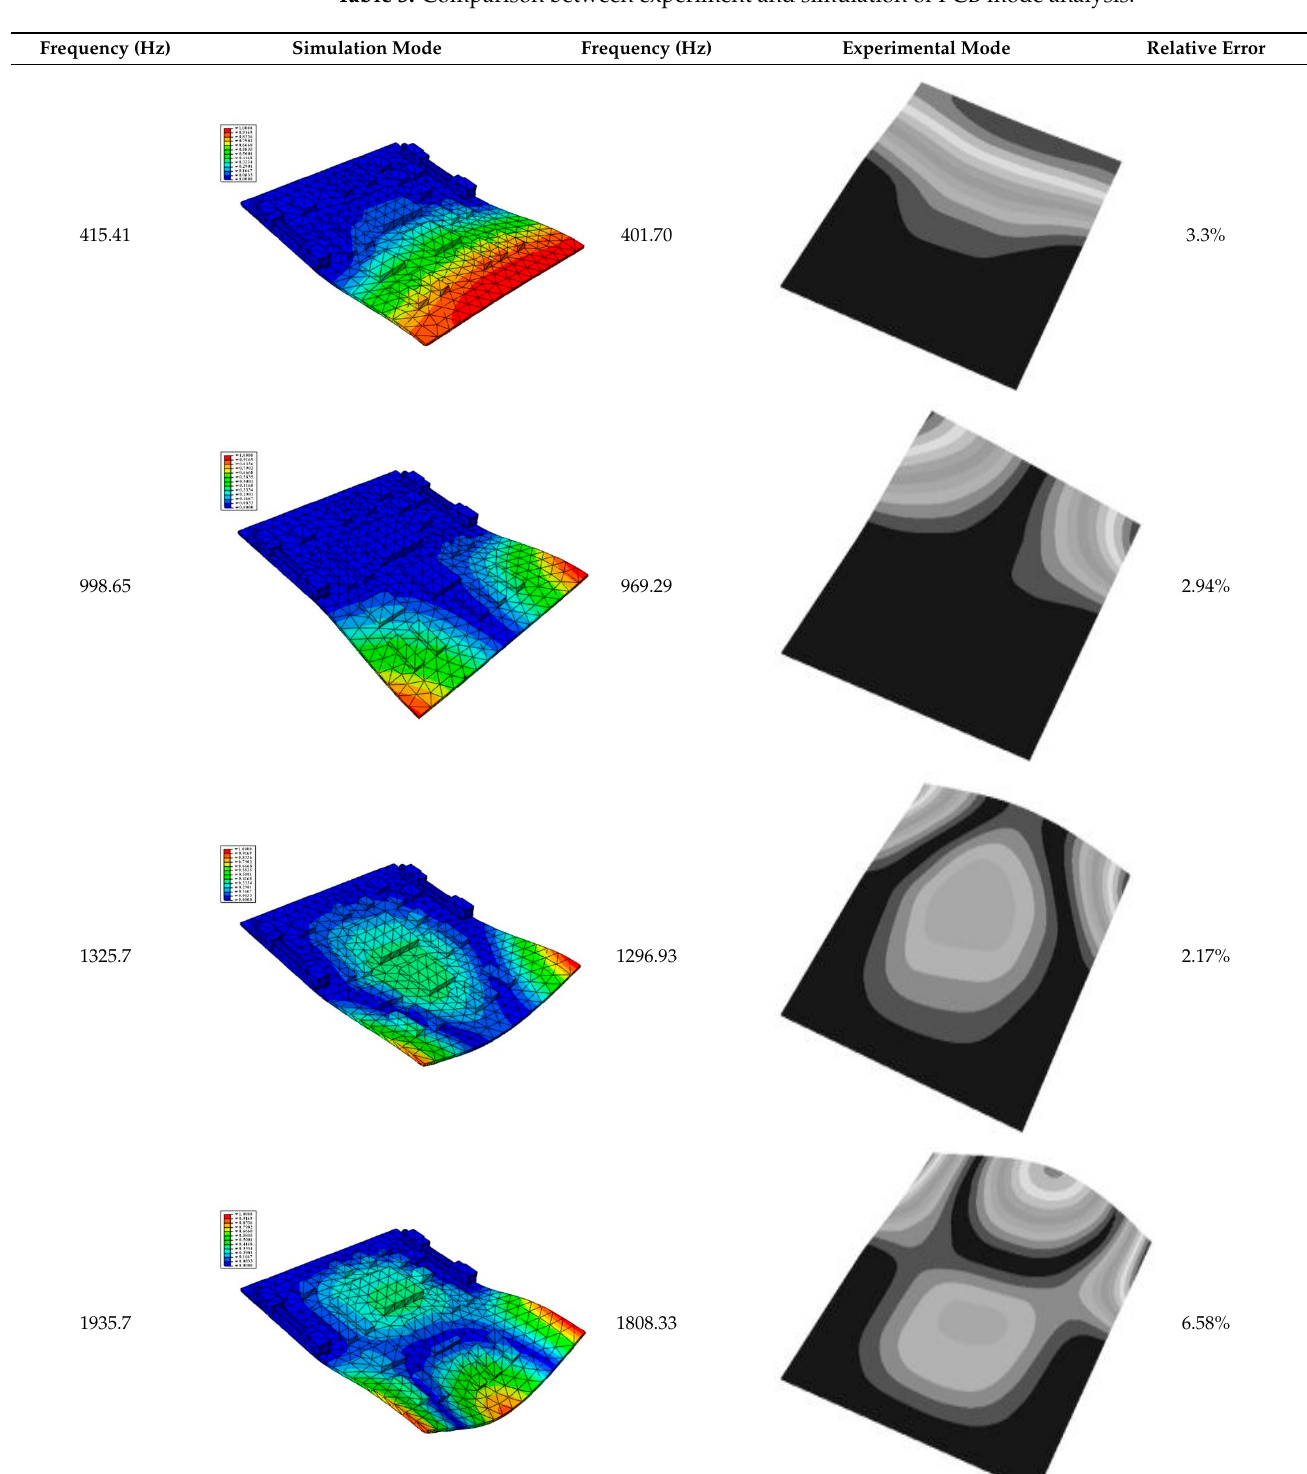
Figure 5. Response output of node C21. 3.4. Harmonic Response Analysis Based on the results of the modal analysis, harmonic response analysis was carried out by modal superposition to obtain the curves of stress vs. frequency and strain vs. fre- quency of the CPU board. Different harmonic loads with different frequencies were con- sidered, and the peak value of the dynamic response was found. To obtain the response peak of the locations at which faults occur more easily, such as the chip pins and welding points, ten reference points (RPs) were defined on the board, as shown in Figure 6. RP 1, 4 and 7 are welding points, and the others are chip pins. The ten nodes corresponding to the ten RPs are listed in Table 4.